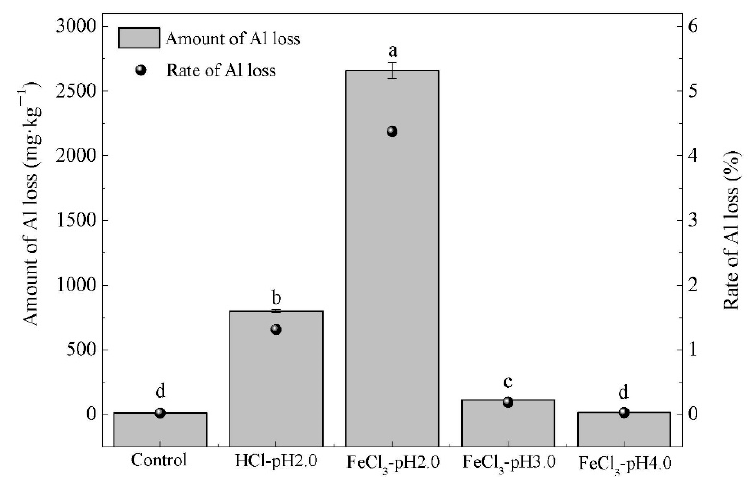
Figure 4. Al release from differently treated soils into solutions. Lowercase letters compare different treatments at the equilibrium stage. Bars followed by the same letter do not differ significantly according to Duncan’s test ( p < 0.05).